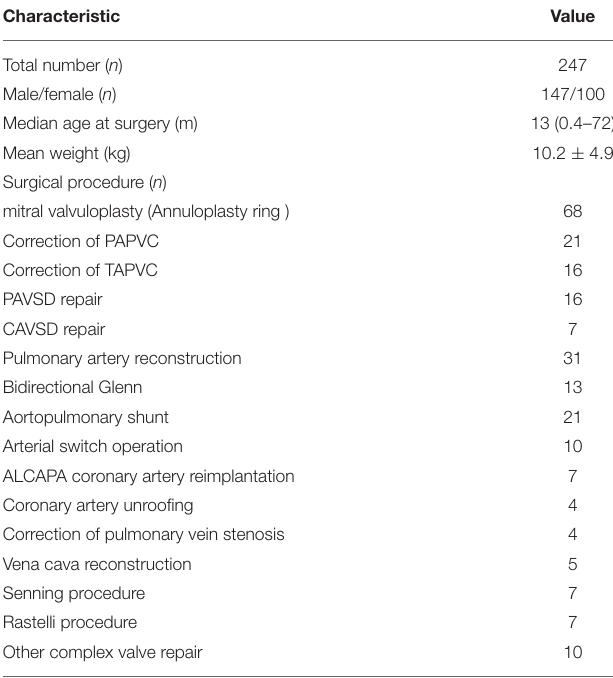
TABLE 1 | Demographics and surgical